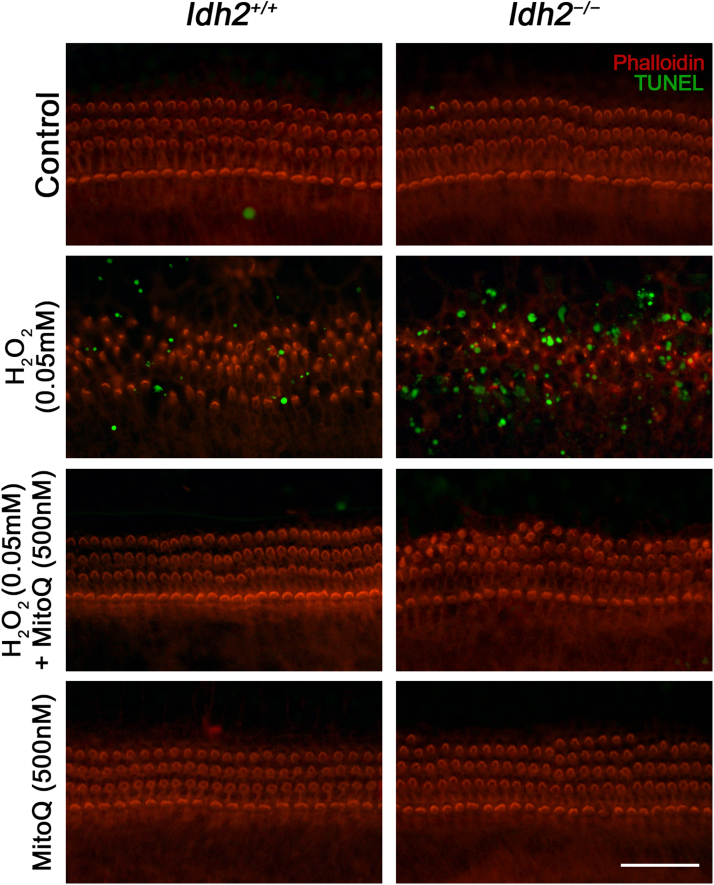
Inhibition of apoptosis by MitoQ in H2O2-treated cochlear hair cells. Apoptotic cell death were determined by a TUNEL assay in cochlear explants of Idh2+/+ and Idh2−/− mice. Microscopic images represent TUNEL (green) and phalloidin (red) labeled cells. Scale bars: 50 µm.